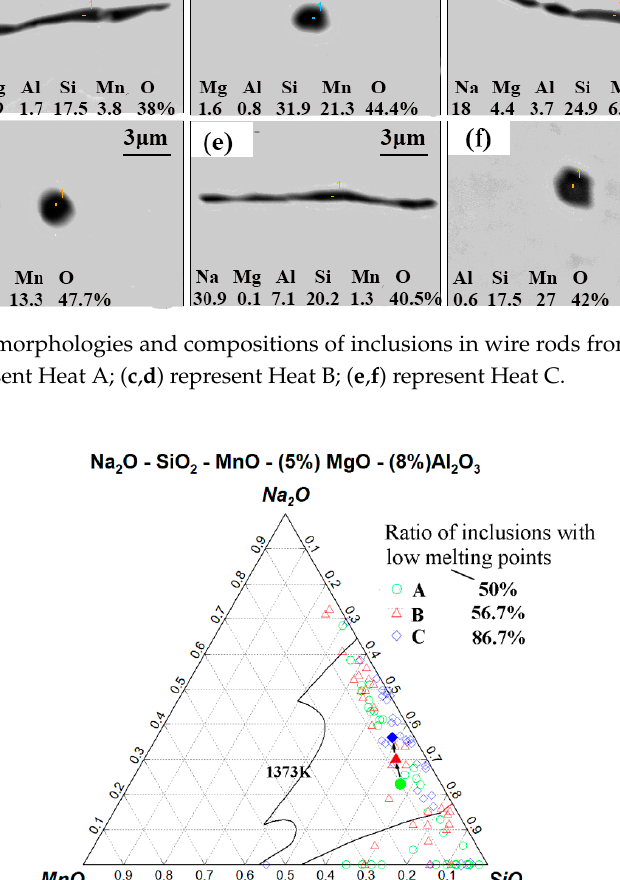
Figure 6. Distribution of inclusions in wire rods from Heats A, B and C. Solid symbols represent the average composition in each heat.